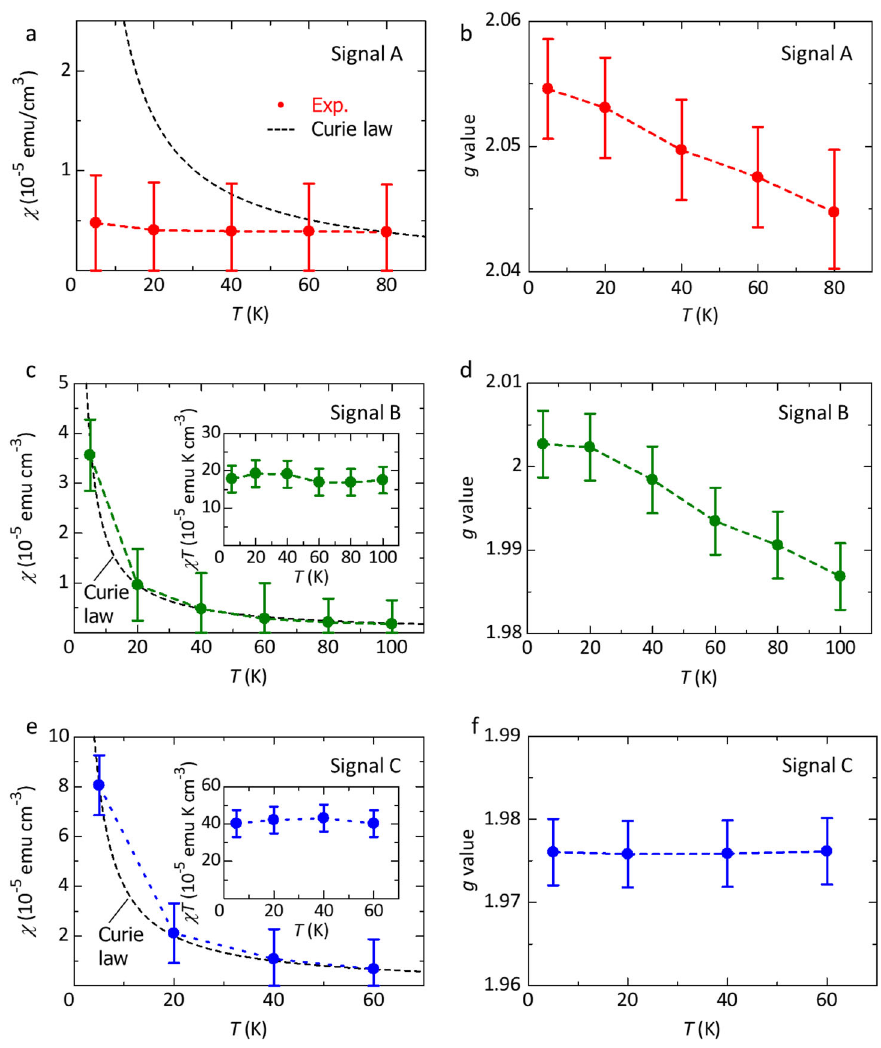
Fig. 4 Temperature dependence of spin susceptibility and g -factor. a , c , e Temperature dependence of the spin susceptibility ( χ ) of the Signals A, B, and C, respectively. In c , e , the plot of χ T – T of the Signals B and C is shown, respectively. b , d , f Temperature dependence of the g -factor of Signals A, B, and C, respectively. The error bars in a , c , e and in b , d , f represent the errors from the double integral and baseline ’ s distortion of the difference ESR spectra shown in Fig. 3b, d, f,